Question: In one sentence, what is this figure communicating?
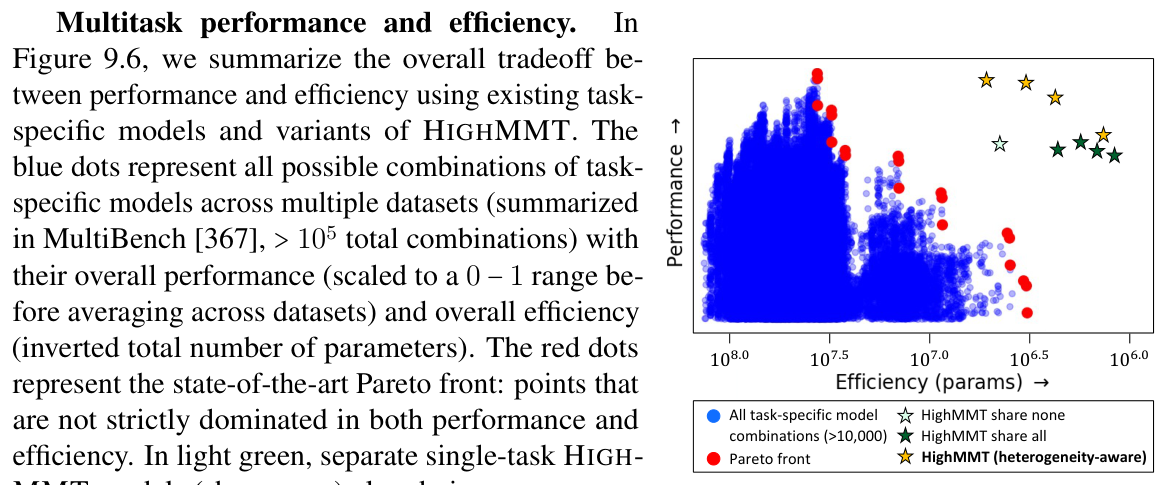
Answer: 1: Heterogeneity quantification: Efficiently learning from many modalities requires measuring (1) modality hetero- geneity: which modalities are different and should be separately processed, and (2) interaction heterogeneity: which modality pairs interact differently and should be separately fused. HIGH- MMT uses these measurements to dynamically group parame- ters balancing performance and efficiency.